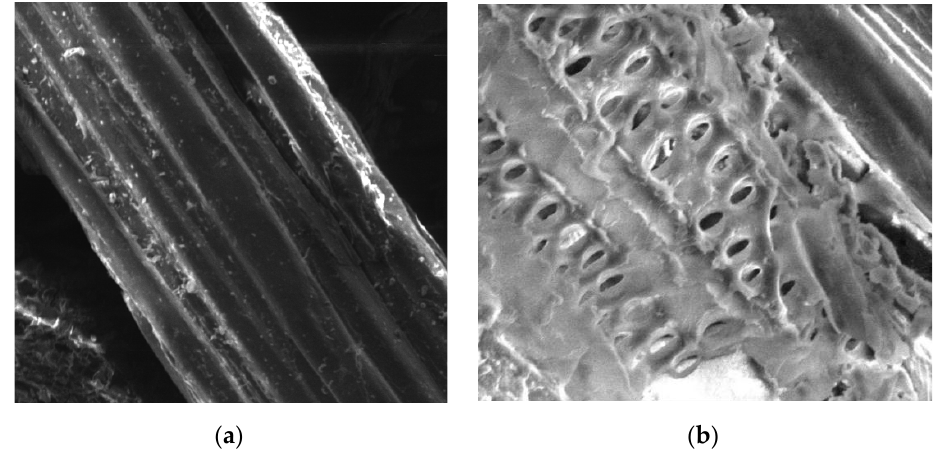
Figure 2. Surface morphology of CS, SCS. ( a ) CS. ( b ) SCS.